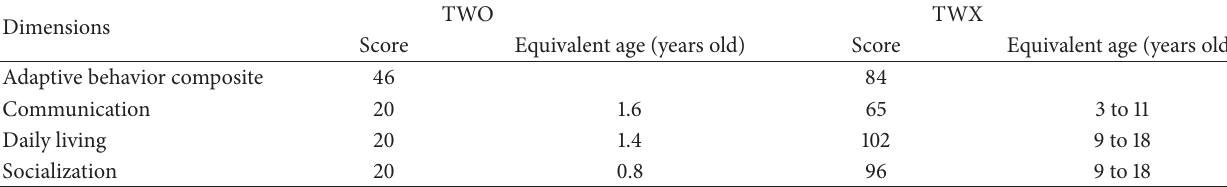
Table 2: Comparative evaluation of TWO and TWX according to Vineland adaptive behavior scale (VABS).